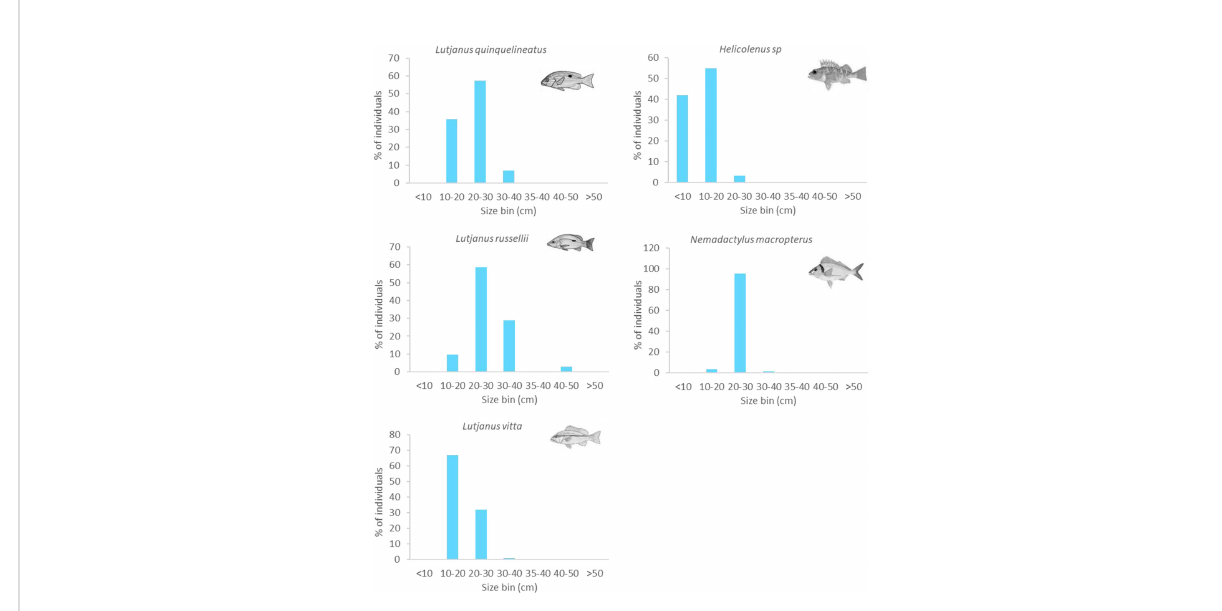
FIGURE 11 Size frequency of abundant fi shery target species observed on subsea pipelines. Sizes estimated from imagery in 10-cm